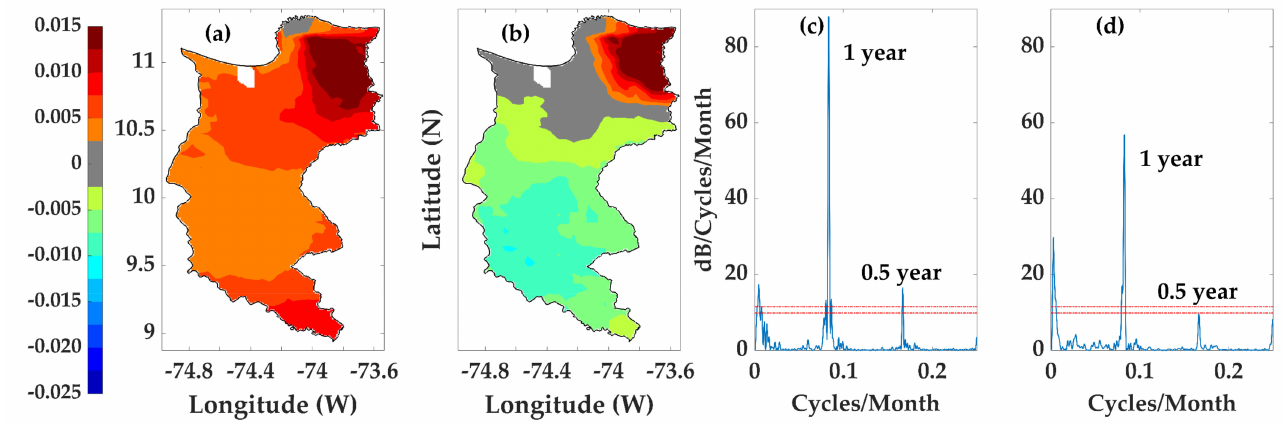
Figure 8. Empirical orthogonal function (EOF) analysis based on the CHIRPS v2.0 database. ( a ) First variability mode—EOF1 and ( b ) second variability mode—EOF2. ( c ) Spectrum of PC1 during 1981–2018. ( d ) Spectrum of PC2 during